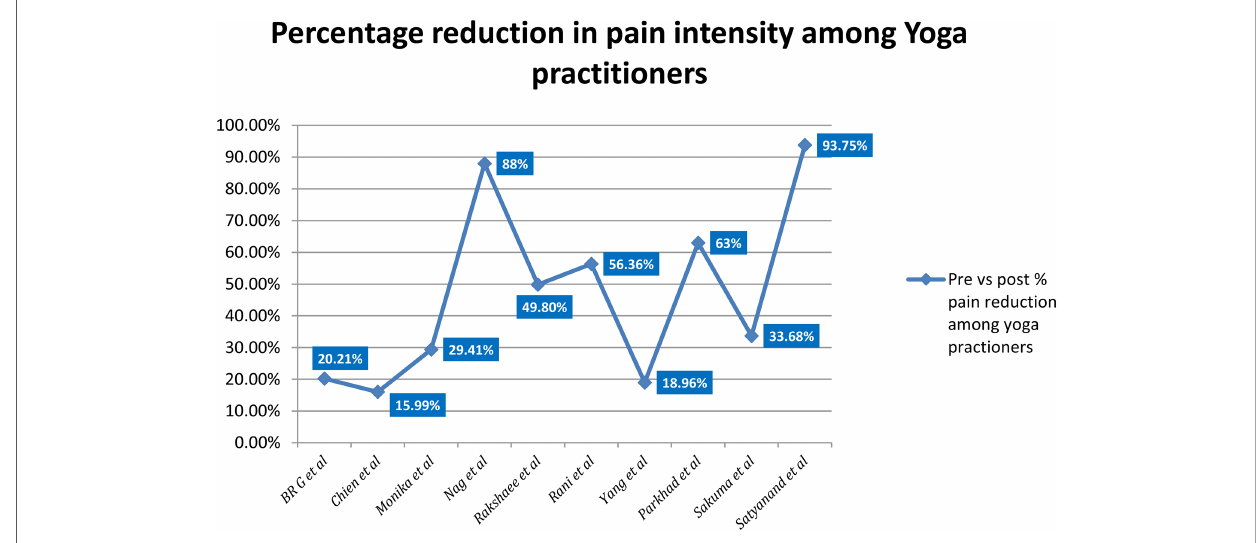
FIGURE 3 Graphical representation of percentage reduction in pain intensity among the yoga